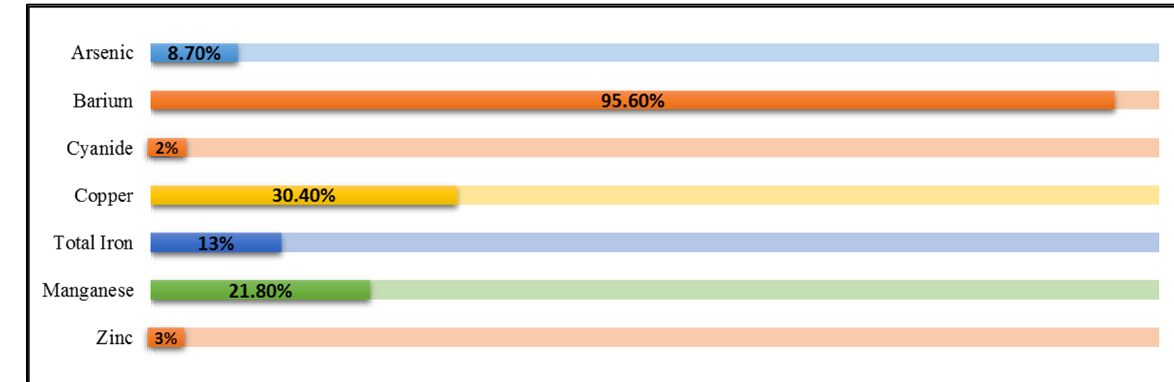
Figure 5. Percentage of samples containing measurable trace elements.